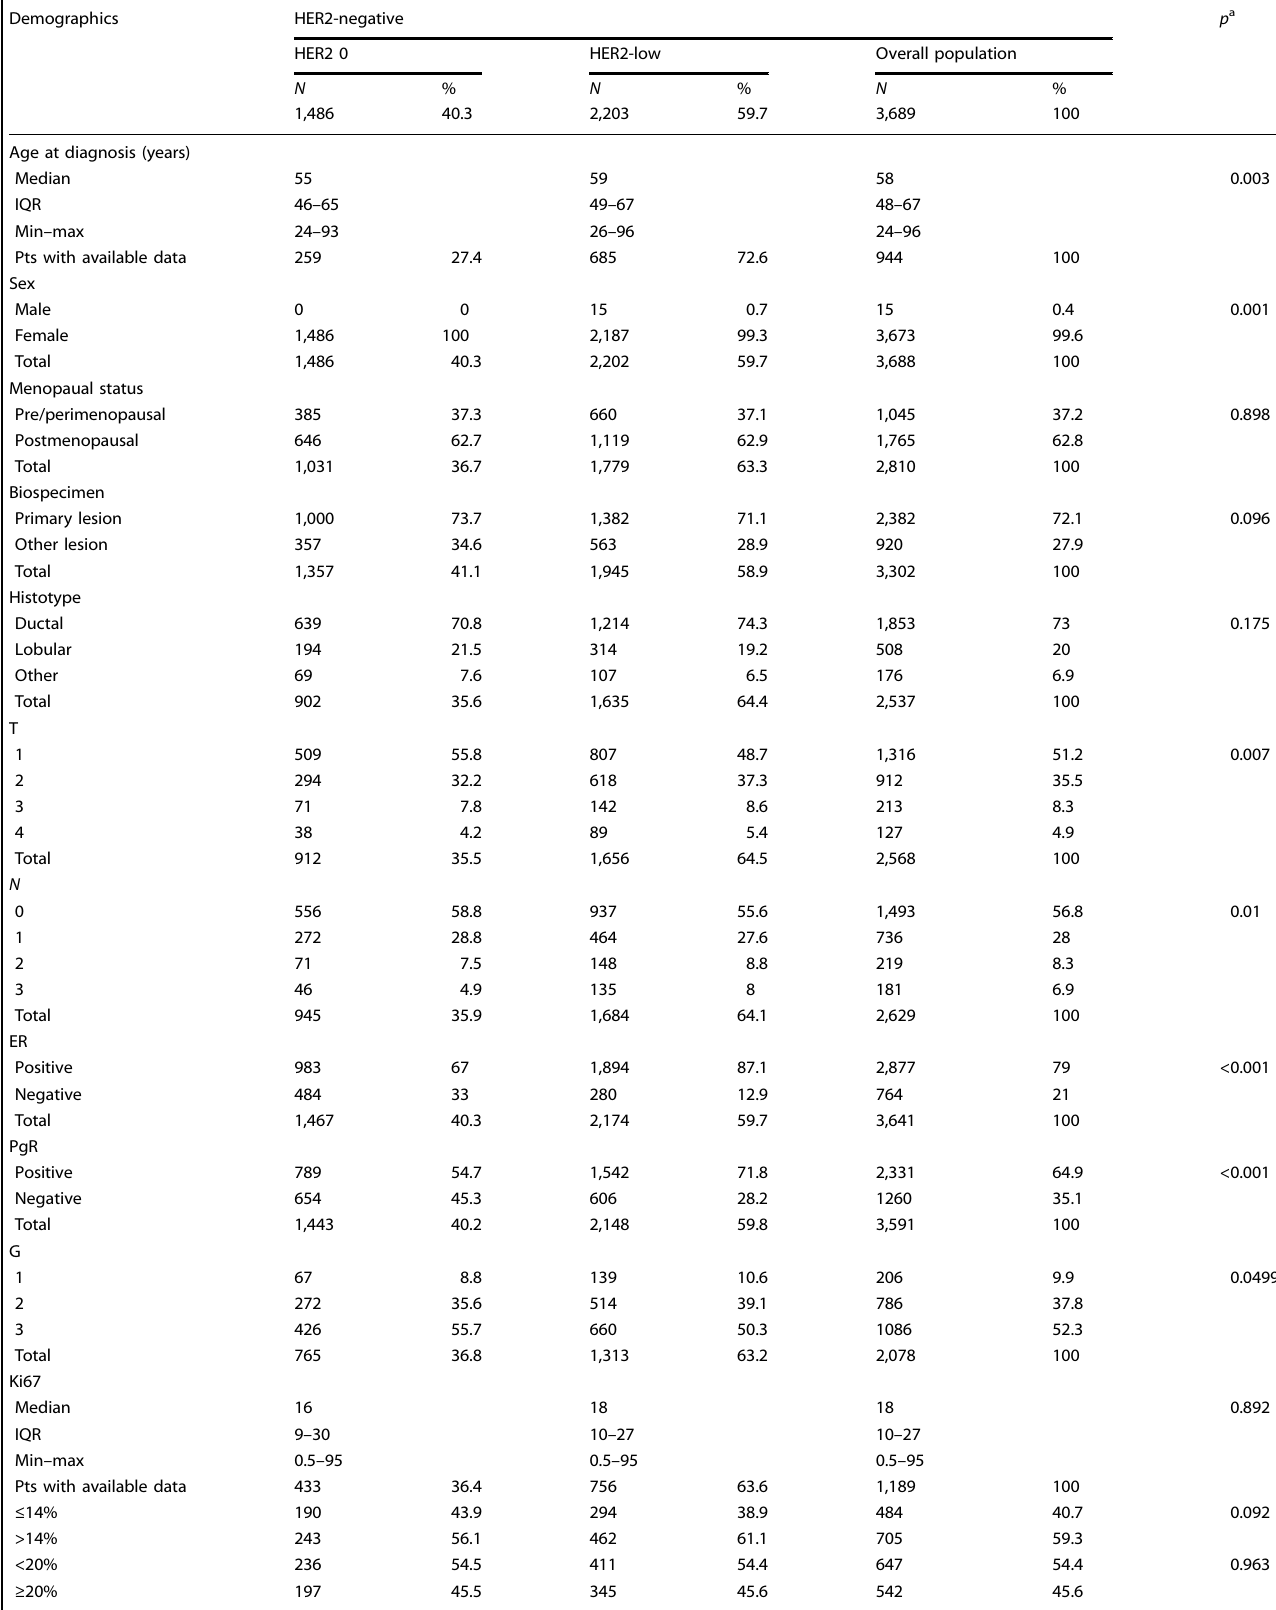
Table 1. Population characteristics according to HER2